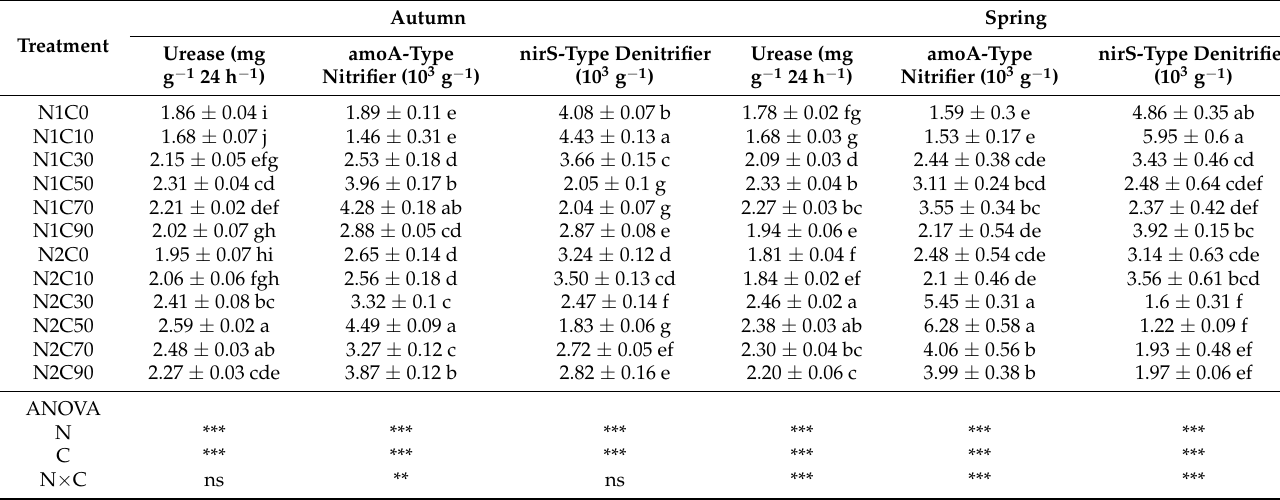
Different lowercase letters denote significant differences among treatment means at the 0.05 level by Duncan’s MRT method. The bottom of this table reports the significant results of the two-way ANOVA. **, and *** indicate significance levels at p < 0.01, and p < 0.001, respectively; ns denotes no significance. Values are means ± standard errors of the